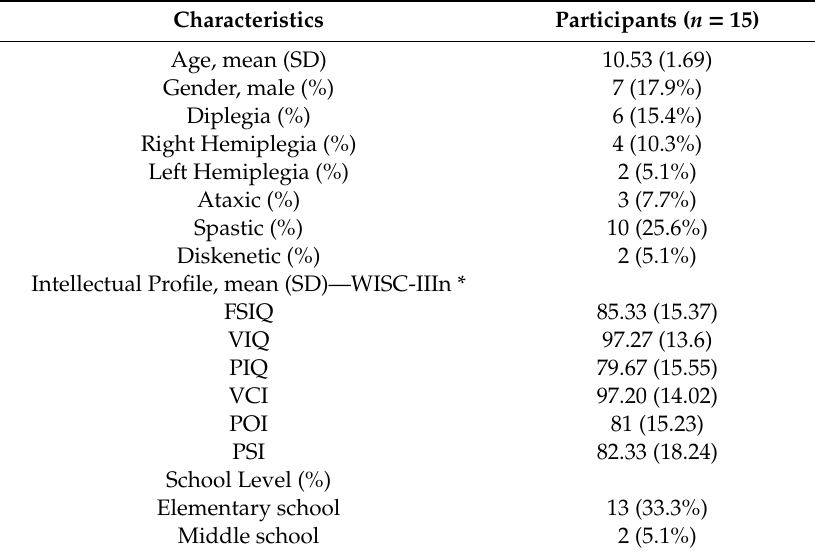
Table 1. Study participants’